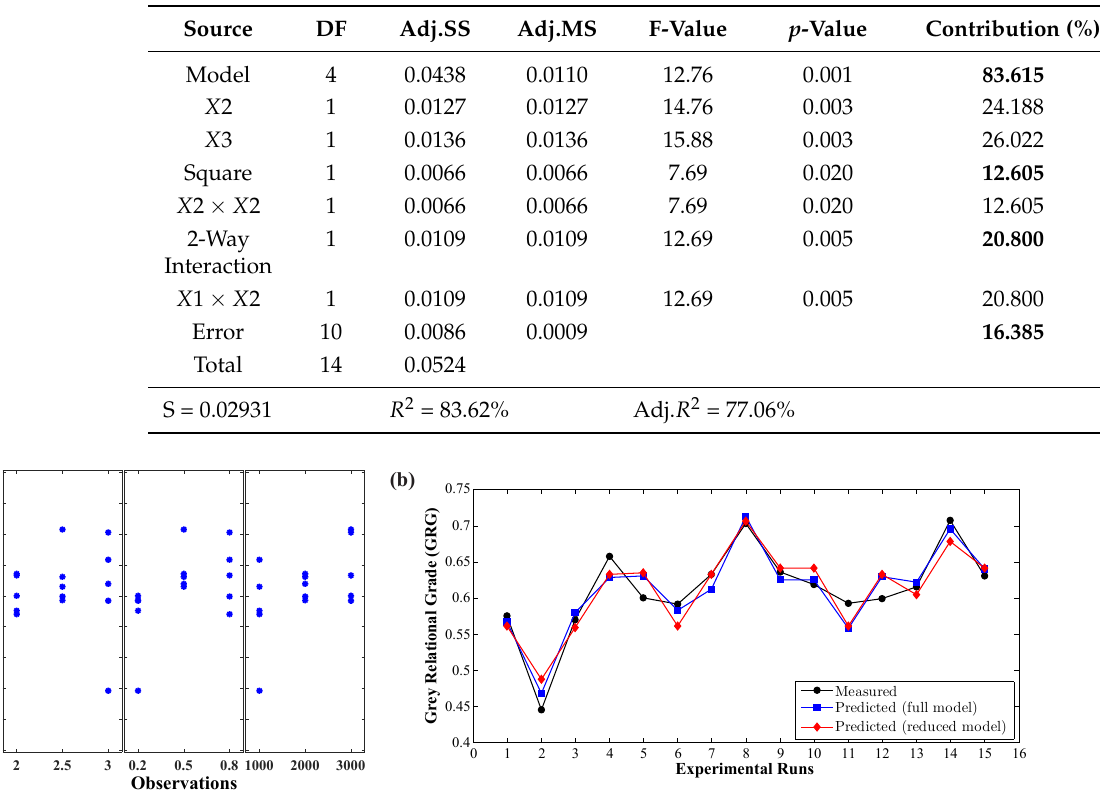
Table 12. Analysis of variance (ANOVA) for GRG values.